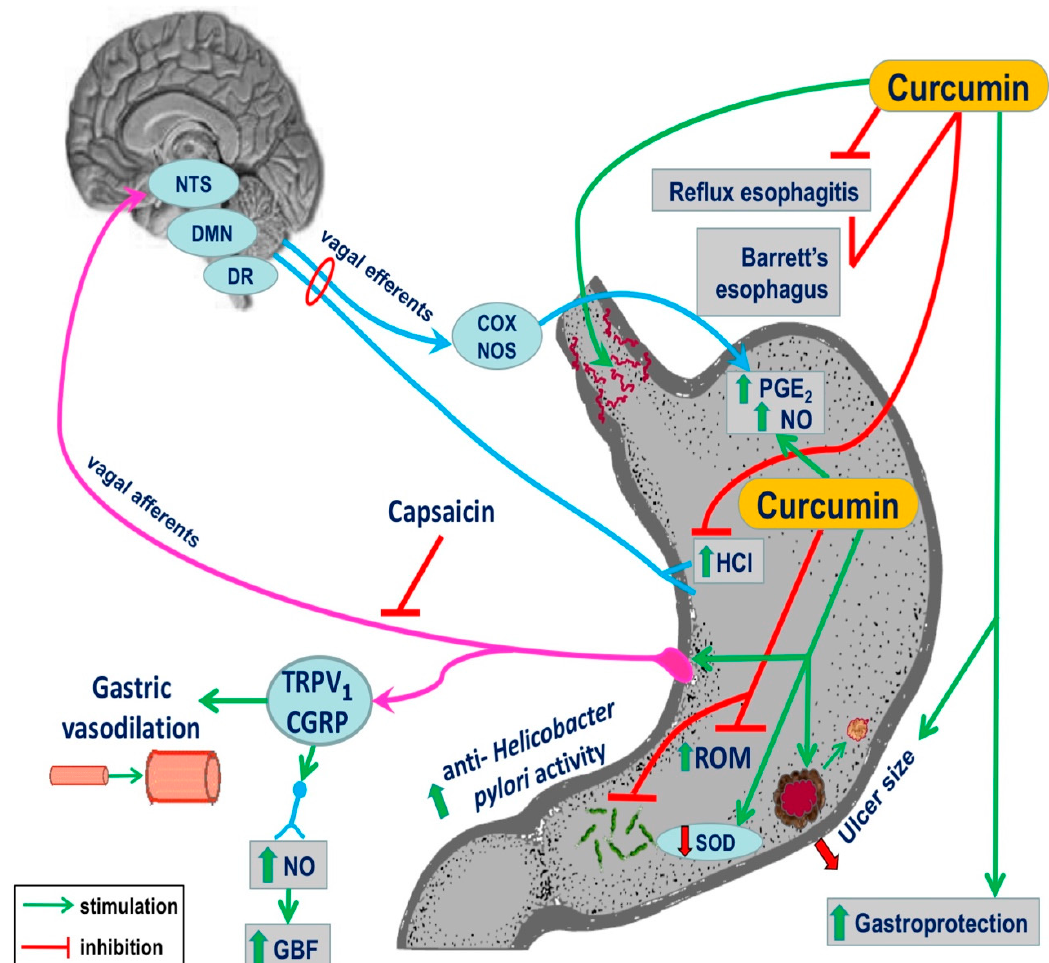
Figure 2. The complex summary of the beneficial effect of treatment with curcumin in esophageal and gastric protection: It involves the amelioration of damage induced by reflux esophagitis and incidence of Barrett’s esophagus, attenuation of inflammation, prevention of gastric damage formation, the anti- Helicobacter pylori activity, and an improvement of communication between gut function and the brain (gut–brain axis) by this turmeric derivative to facilitate local microvascular vasodilation and an increase in organ blood flow, gastroprotection, and ulcer healing.